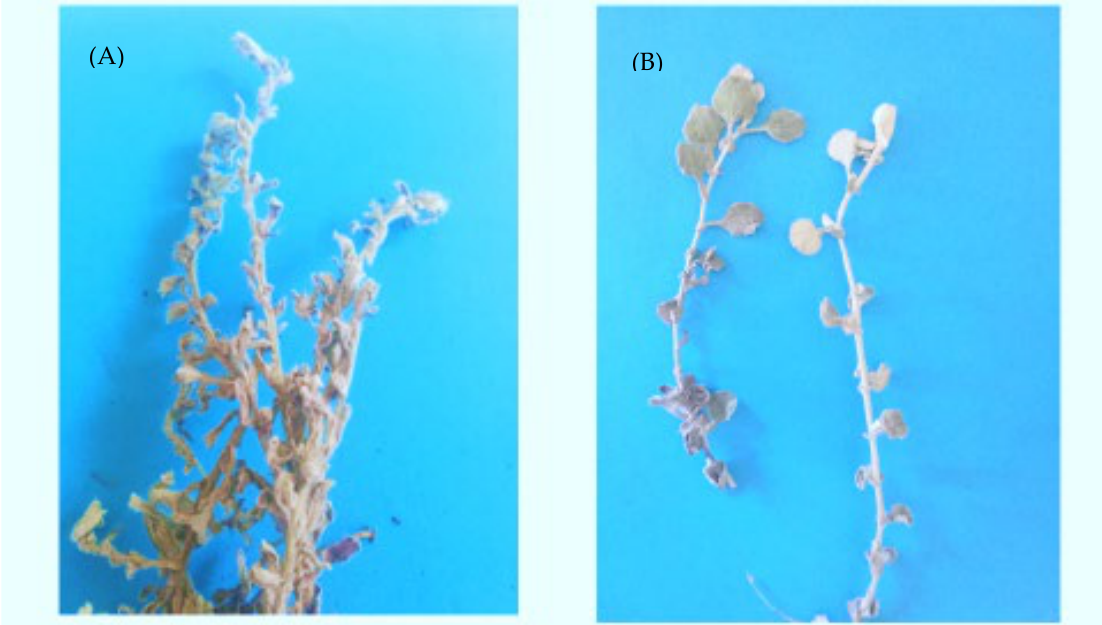
Figure 2. Pictures of the two Helichrysum odoratissimum ( A ), and Helichrysum patulum ( B ) were investigated in the study.